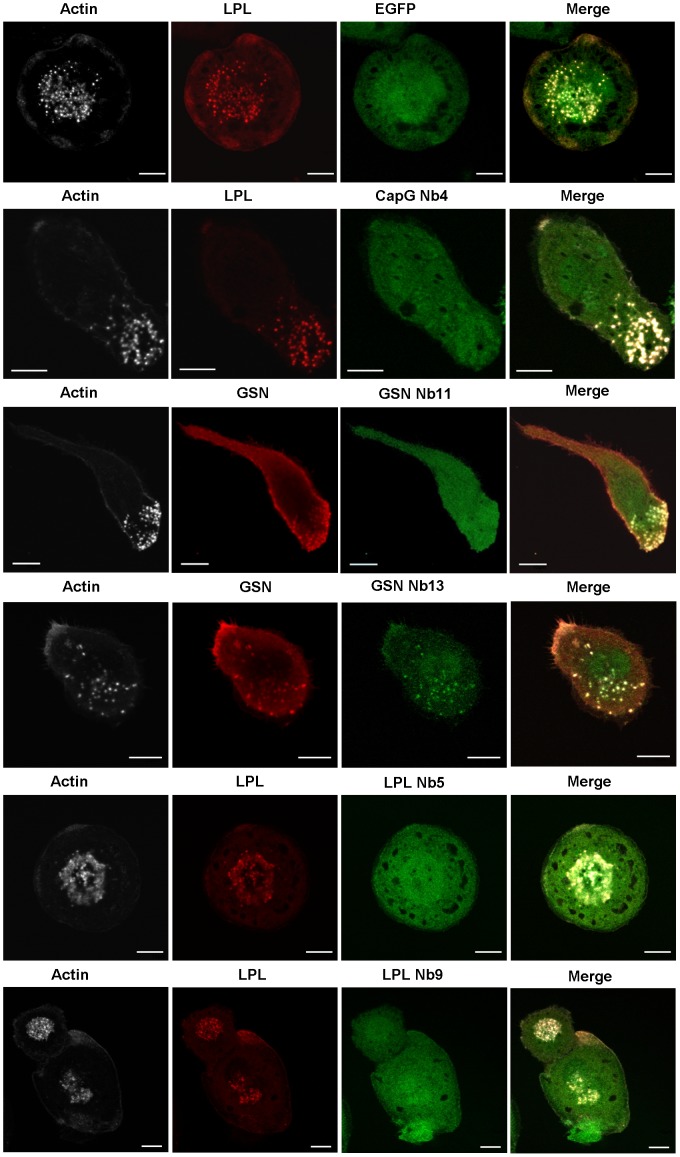
L-plastin Nbs perturb podosome formation in PMA-stimulated THP-1 cells.Cells were incubated with PMA for 72-tagged LPL/CapG/GSN Nbs or EGFP was induced by 24 hr incubation with doxycycline (0.5 µg/ml). Cells were stained for F-actin (phalloidin 670, far red, shown in grey) and L-plastin or gelsolin (alexa-594, red). EGFP and EGFP-tagged nanobodies are shown in green. The pictures were acquired with a confocal laser scanning microscope and are representative for four independent experiments. Bar: 10 µm.